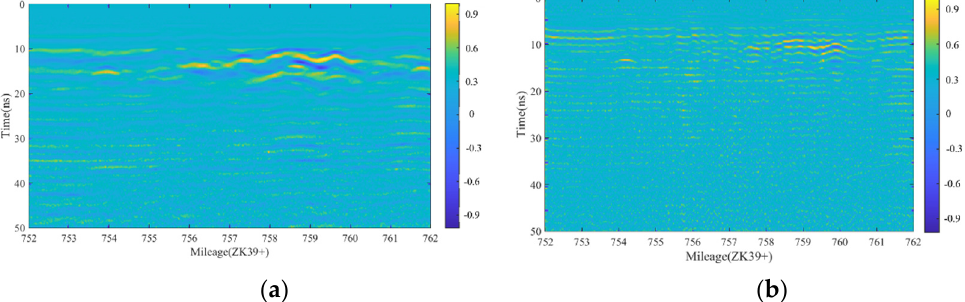
Figure 10. Radar images after preprocess show a distinct layer of rebar reflections, but the reinforce- ment is not recognizable. Moreover, due to the multiple reflected wave interference caused by the deformed high reinforcement layer, the thickness of the second-lined structure cannot be identified. ( a ) 400 MHz; ( b ) 900 MHz.